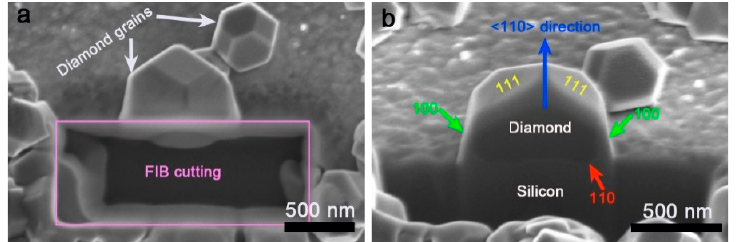
Figure 4. ( a ) Top view and ( b ) cross section of an individual diamond nucleus.